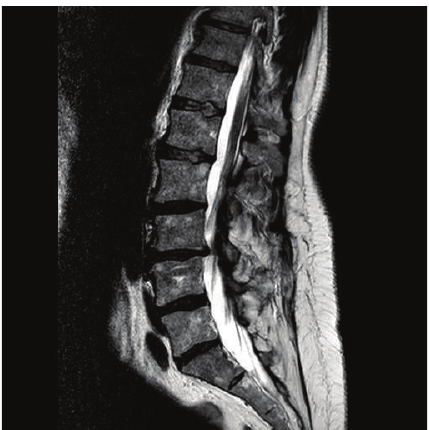
Figure 1: Sagittal T1-weighted MR imaging of the lumbar spine of a 55-yo patient with a previous rigid fixation on L4L5S1 level shows adjacent segment disease at the L3L4